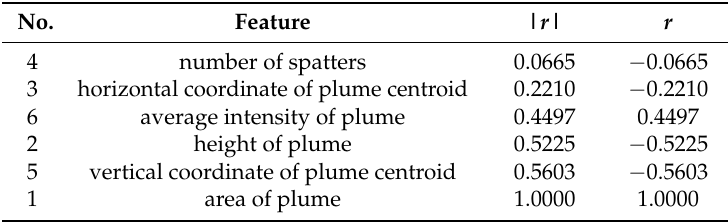
Table 4. Pearson correlation coefficients r between each feature and Feature 1.